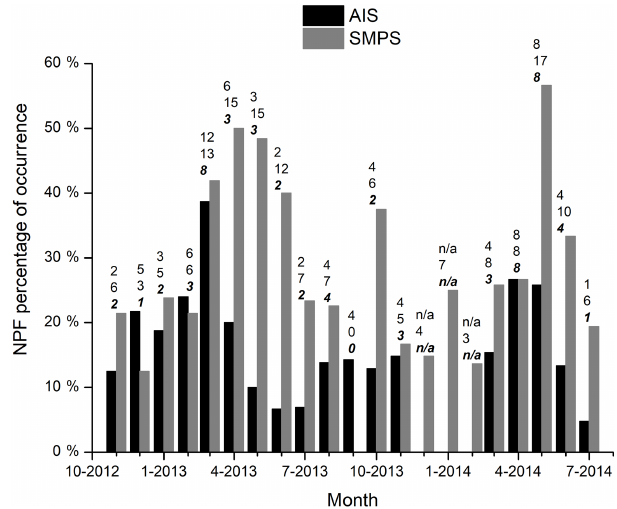
Figure 10. Monthly variability of NPF events’ percentage of oc- currence relatively to available measurement days at Finokalia as determined by analysis of AIS data during the FRONT experiment (November 2012–July 2014). For a direct comparison, the monthly variability of NPF events as obtained from the SMPS measurements for the same period is included. Above the columns, the number of NPF events observed for AIS (top), SMPS (middle) and the num- ber of common events for both instruments (bottom, italic, bold) for each month are